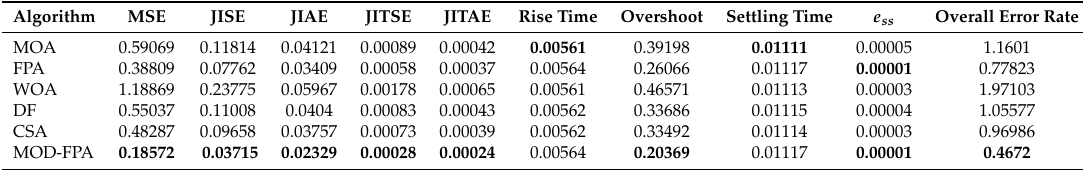
Figure 3. Speed tracking task without load and nominal parameters condition. Table 5. Performance analysis for speed tracking task without load and nominal parameters condition.